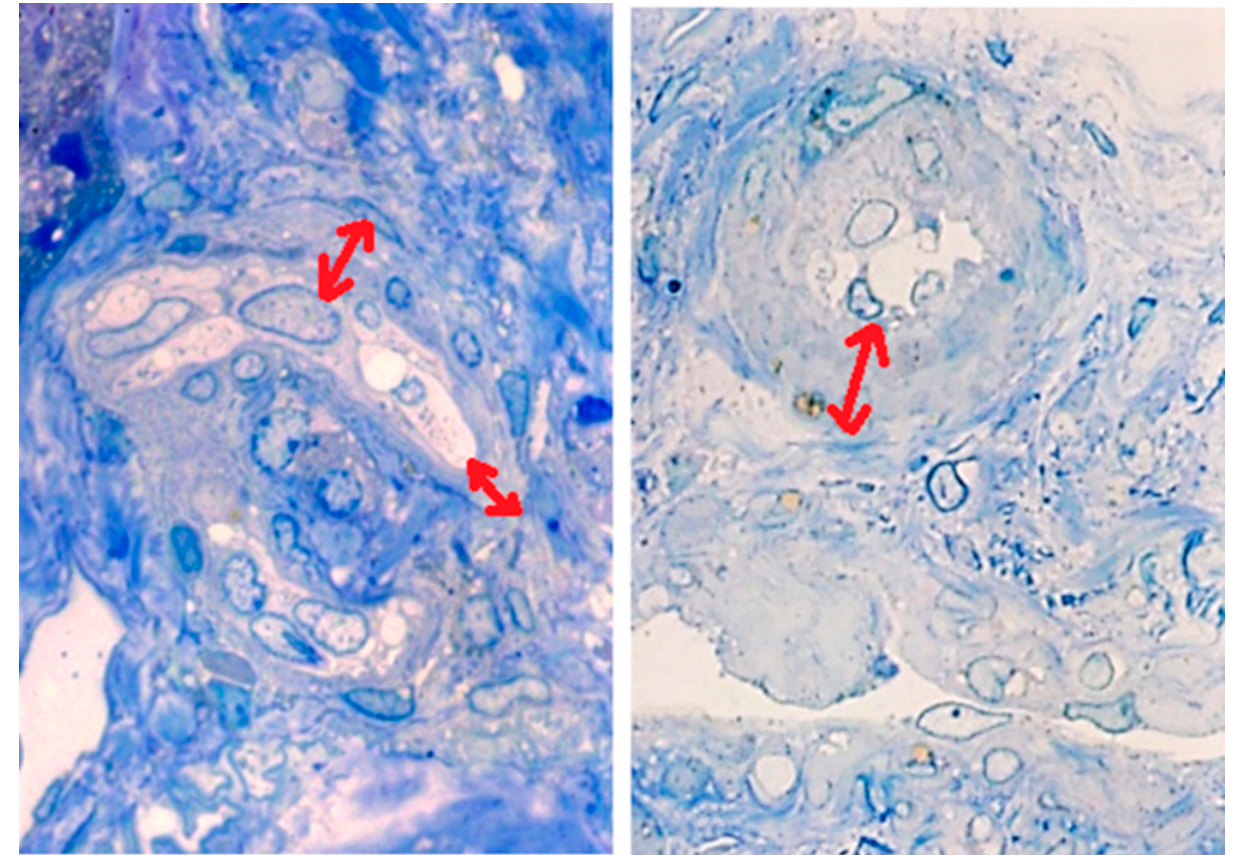
Figure 2. Light microscopy. Lesions suggesting endotheliosis luminal shrinkage and endothelial hyperplasia (red double arrows) (toluidine blue, 40× magnification).